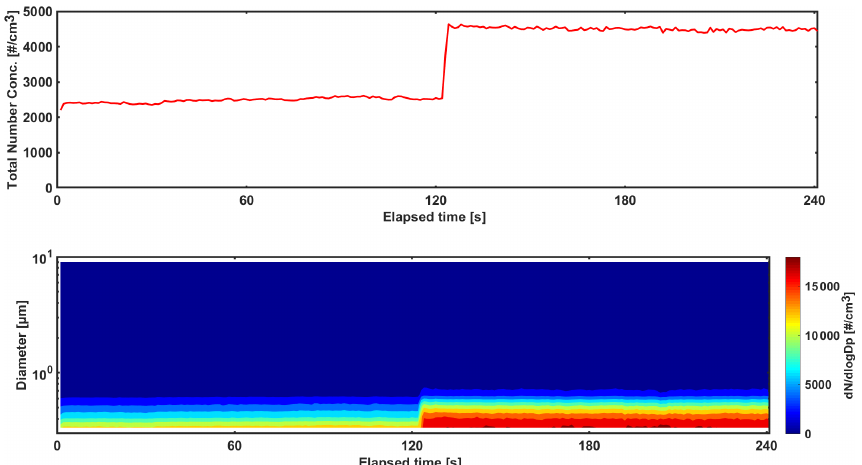
Figure 5. Total particle number concentrations and particle number size distributions as a function of time of aqueous ammonium sulfate particles at 0.6gL − 1 : 0.5mm brass orifice, from 0–120s and 0.5mm printed orifice, from